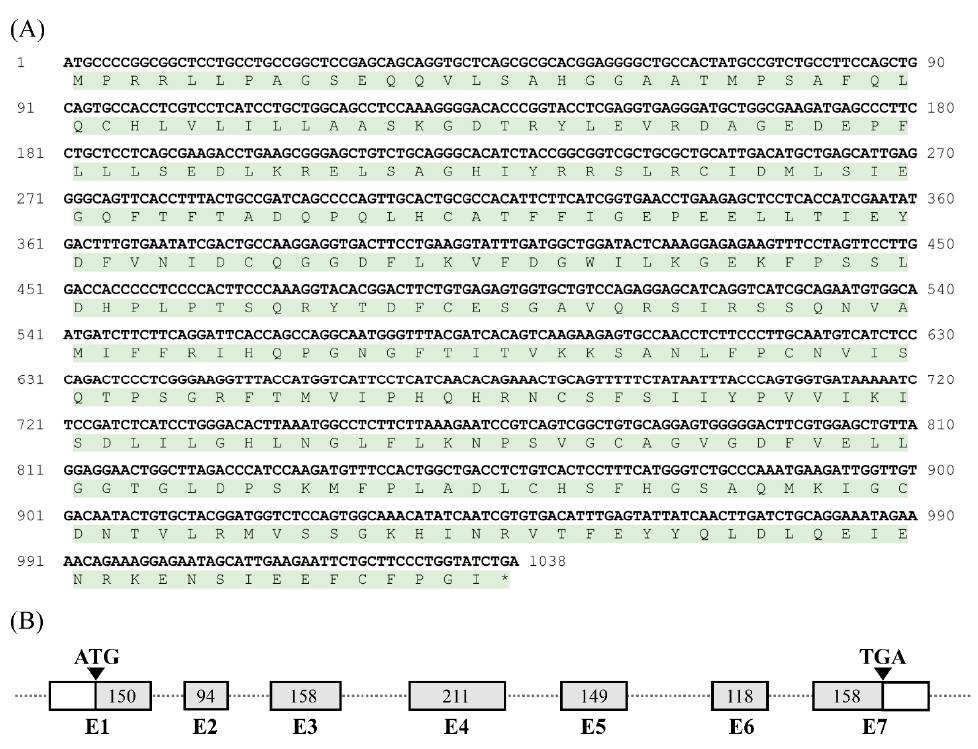
Figure 1. ( A ) The cDNA and deduced amino acid sequence of chicken CRHBP . The amino acids are shaded in green. The asterisk (*) indicates the stop codon. ( B ) Exon (E)-intron organization of chicken CRHBP . cCRHBP consists of 7 exons (E1–E7). The translation start (ATG) and end (TGA) sites are shown by arrows. The coding region of c CRHBP is shaded. The numbers in the boxes indicate the sizes (bp) of coding exons. Exons 1–7 are represented by the letters